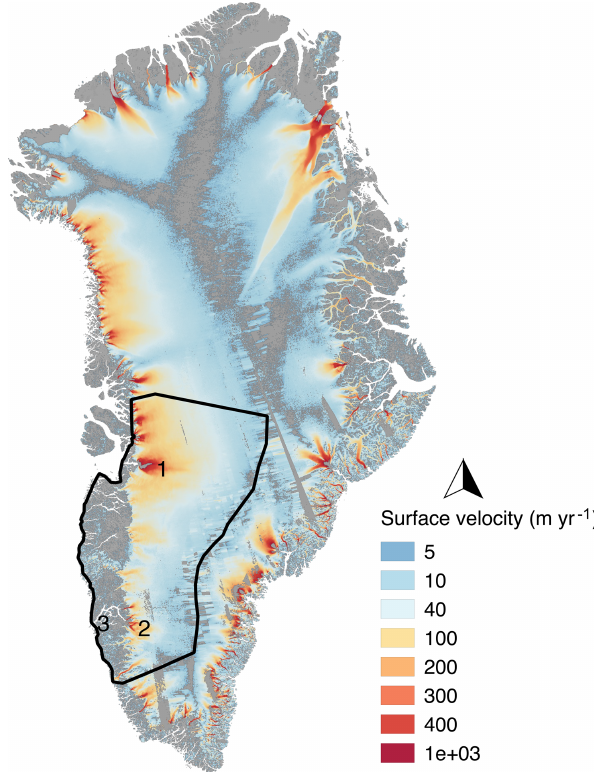
Figure 1. Present-day interferometric synthetic aperture radar (In- Sar) ice surface velocities from Rignot and Mouginot (2012) for the Greenland ice sheet. The regional model domain is highlighted in black. Marked locations correspond to (1) Jakobshavn Isbræ, (2) Kangiata Nunâta Sermia (KNS), and (3)